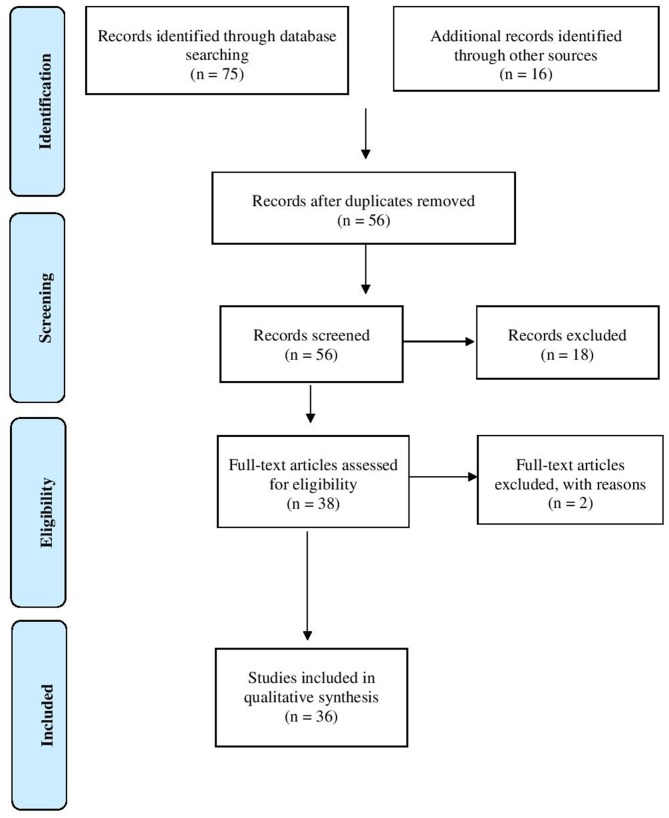
PRISMA flow-chart.